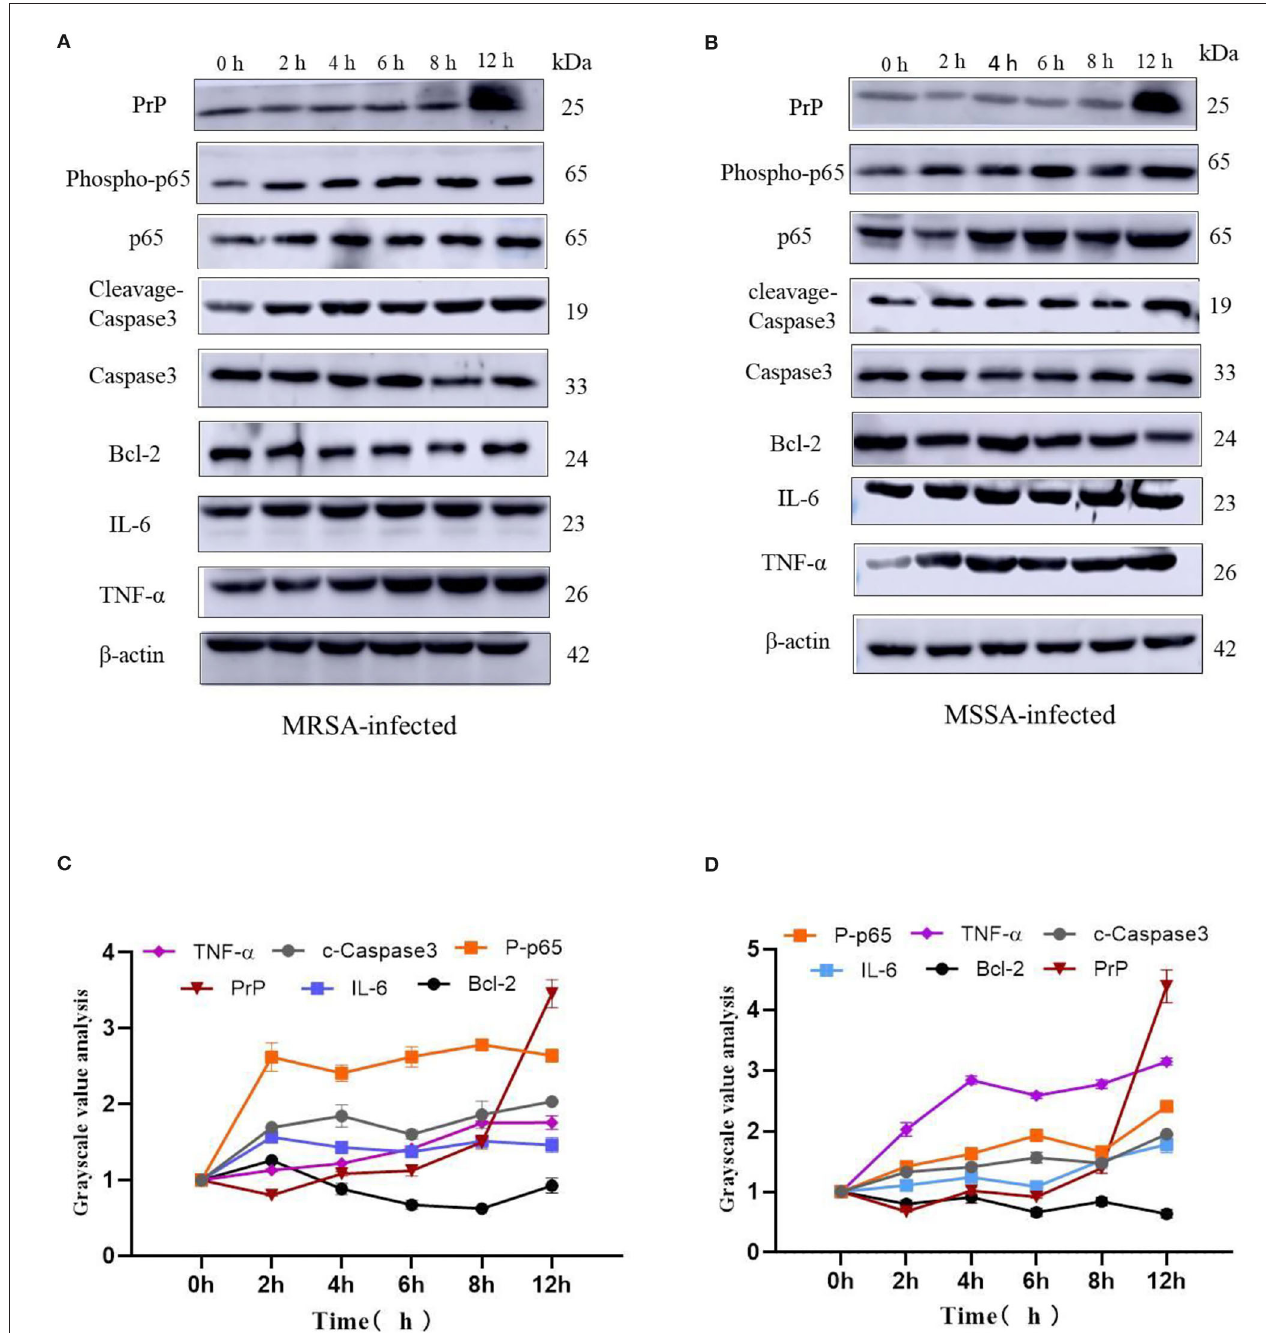
FIGURE 6 | The effects of MRSA-infected and MSSA-infected MAC-T cells on the expression levels of TNF- α , IL-6, Bcl-2, cleavage–Caspase3, Phospho-p65 and PrP. (A) and (B) The MRSA-infected group and MSSA-infected group on the expression levels of TNF- α , IL-6, Bcl-2, cleavage–Caspase3, Phospho-p65, and PrP by Western blotting. (C) and (D) Gray-scale analysis of MRSA-infected group and MSSA-infected group.